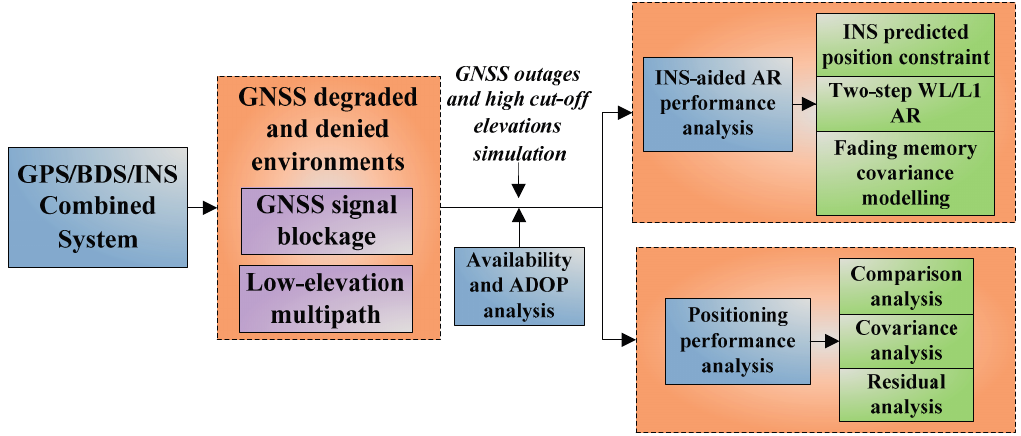
Figure 2. Performance analysis of the GPS/BDS/INS combined system in GNSS degraded and denied environments.